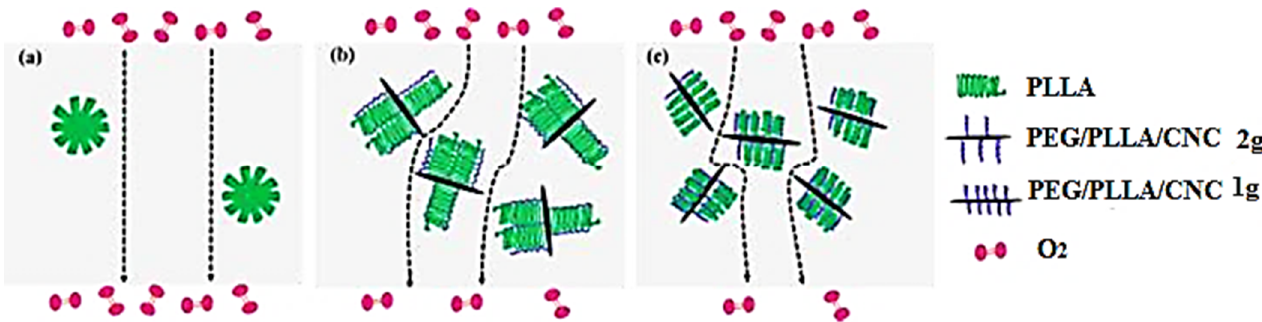
Figure 3. Schematic representation showing crystalline morphological features in ( a ) neat PLLA; ( b ) PLLA/PEG/CNC with 2 g nanofiller; and ( c ) PLLA/PEG/CNC with 1 g nanofiller governing oxygen permeation. The lines represent the diffusion paths of O 2 [70]. PLLA = poly(L-lactic acid); PLLA/PEG/CNC = poly(L-lactic acid) (PLLA)/poly(ethylene glycol)/cellulose nanocrystal. Reproduced with permission from Elsevier.